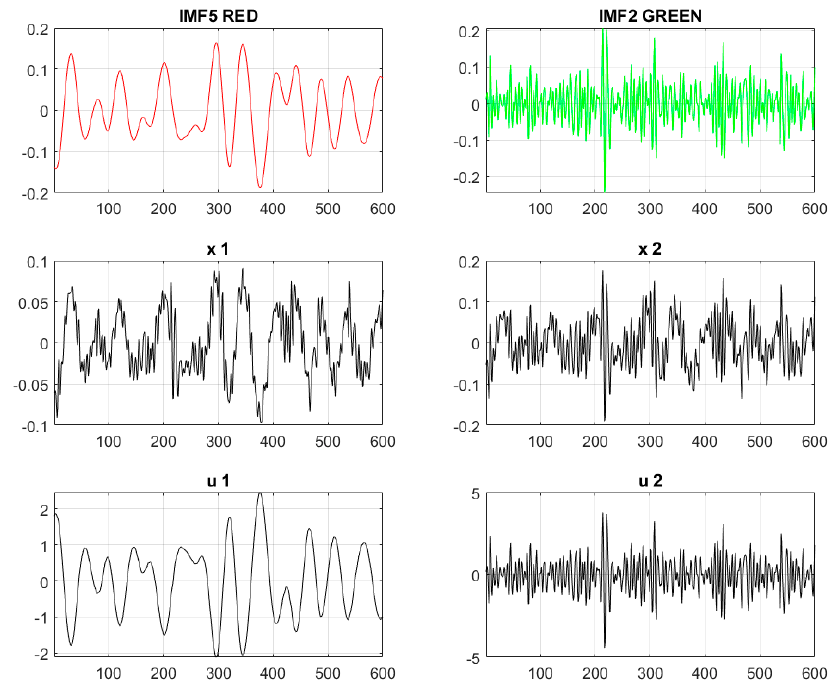
Figure 9. Signals based on the ICA